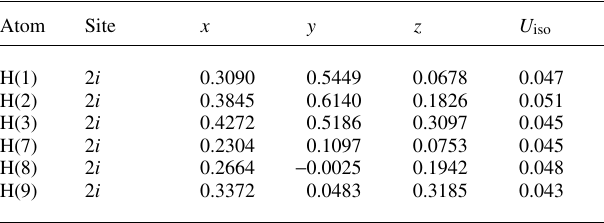
Table 2. Atomic coordinates and displacement parameters (in Å 2 )